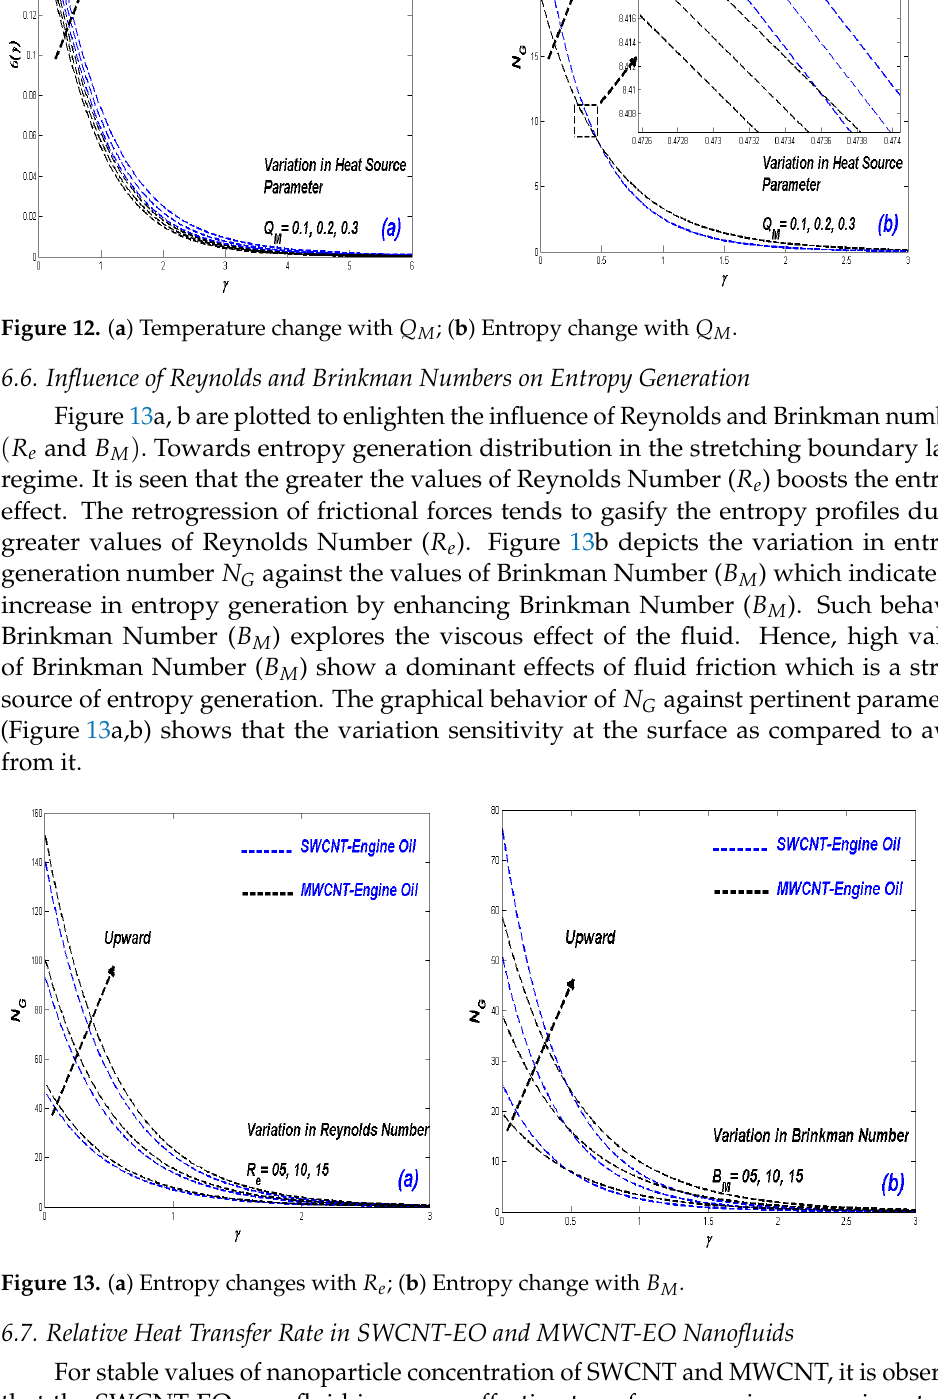
Figure 13. ( a ) Entropy changes with 𝑅 (cid:3032) ; ( b ) Entropy change with 𝐵 (cid:3014) .